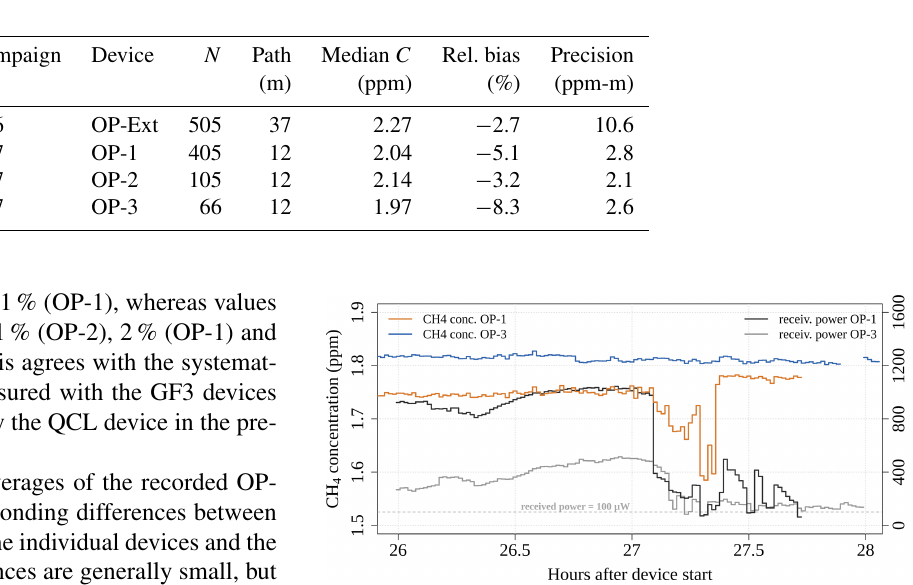
Table 3. Direct comparison of GF3 to QCL (30min averages) during campaigns P16 and P17. N : number of 30min intervals. Path: path length of GF3 device. Median C : median concentration of the GF3 device. Rel. bias: estimate of the GF3 relative bias. Precision: estimate of the GF3 precision.